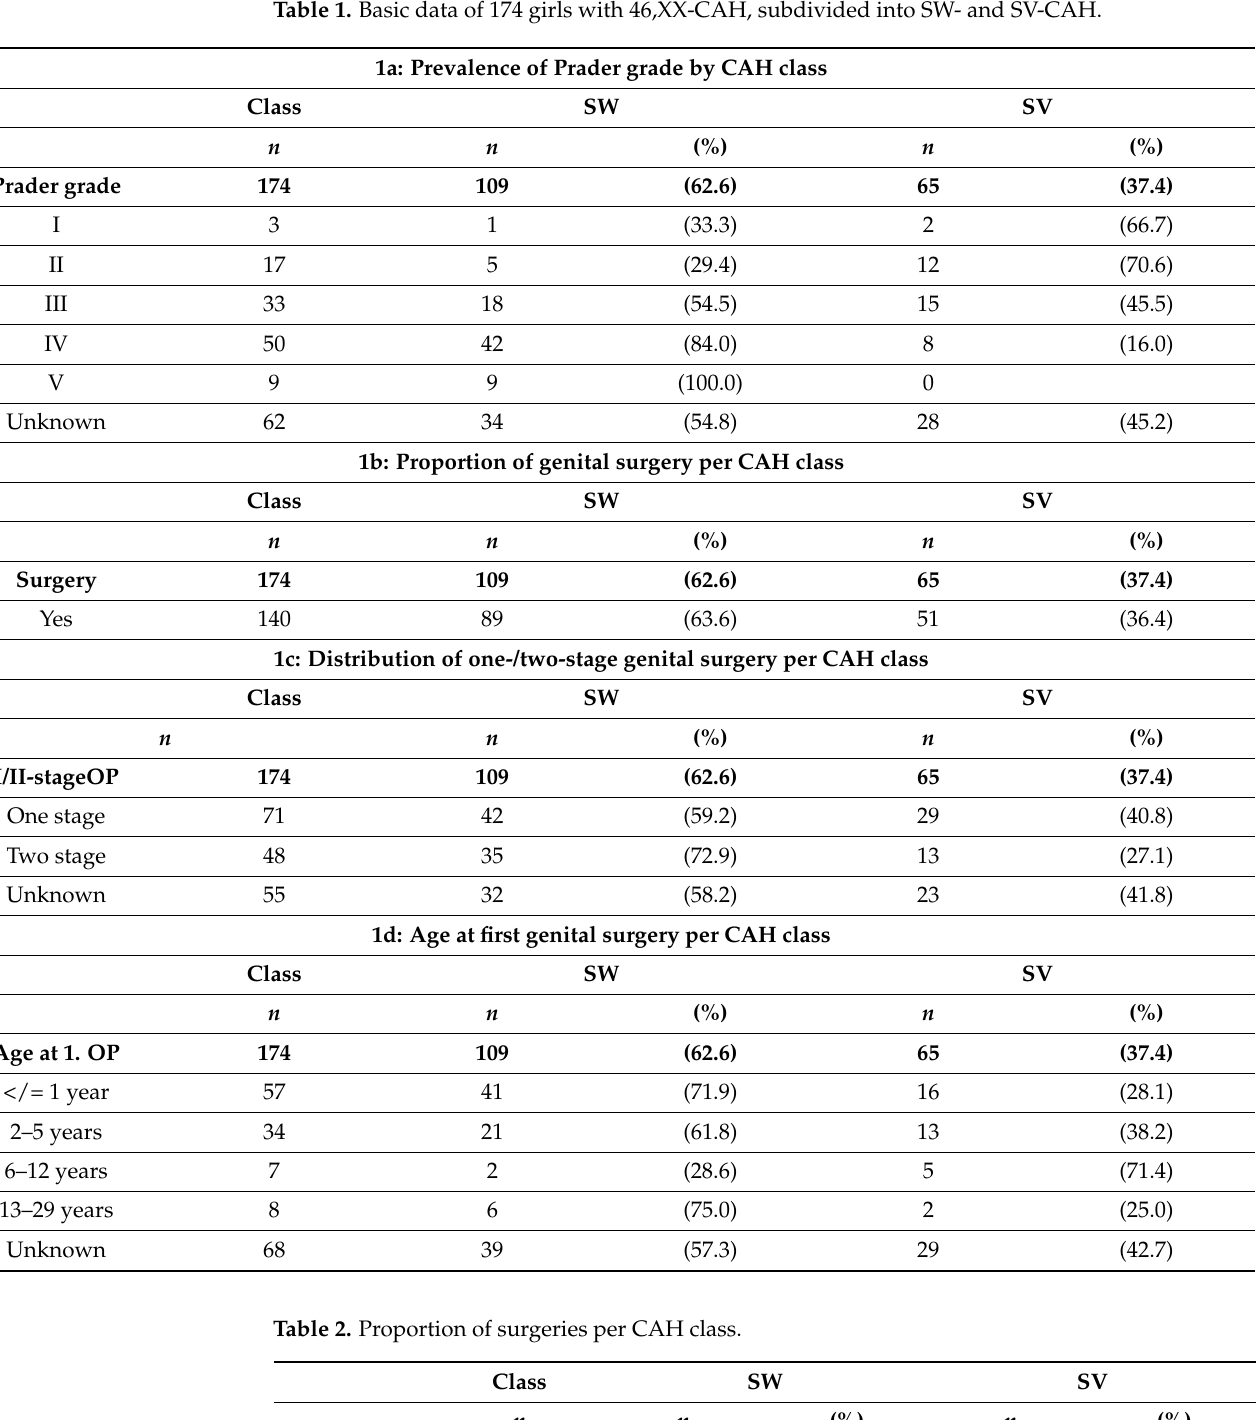
Table 1. Basic data of 174 girls with 46,XX-CAH, subdivided into SW- and SV-CAH.